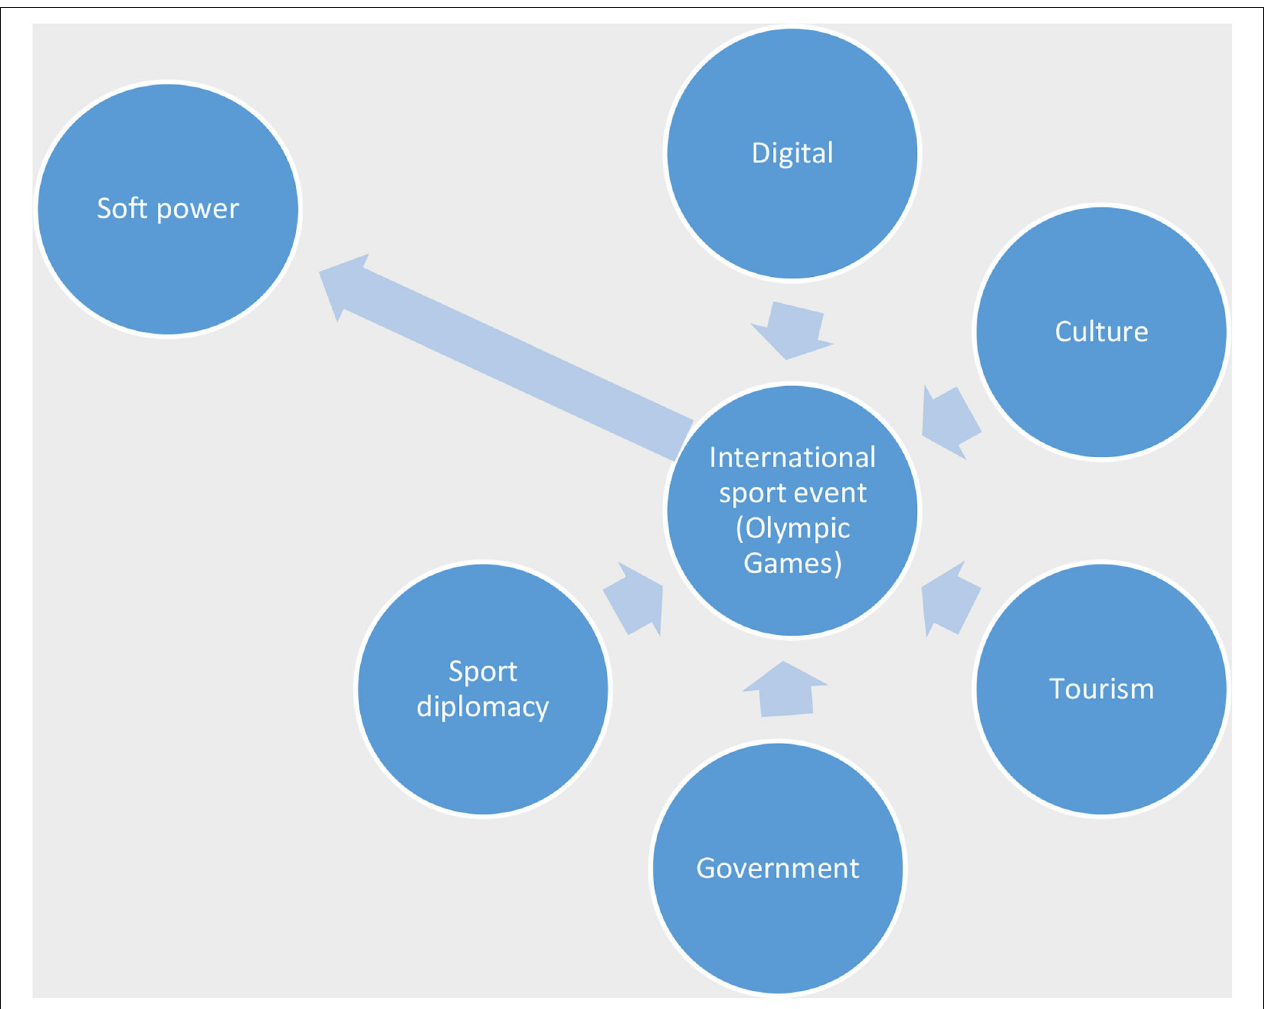
FIGURE 2 | Component of soft power and international sport